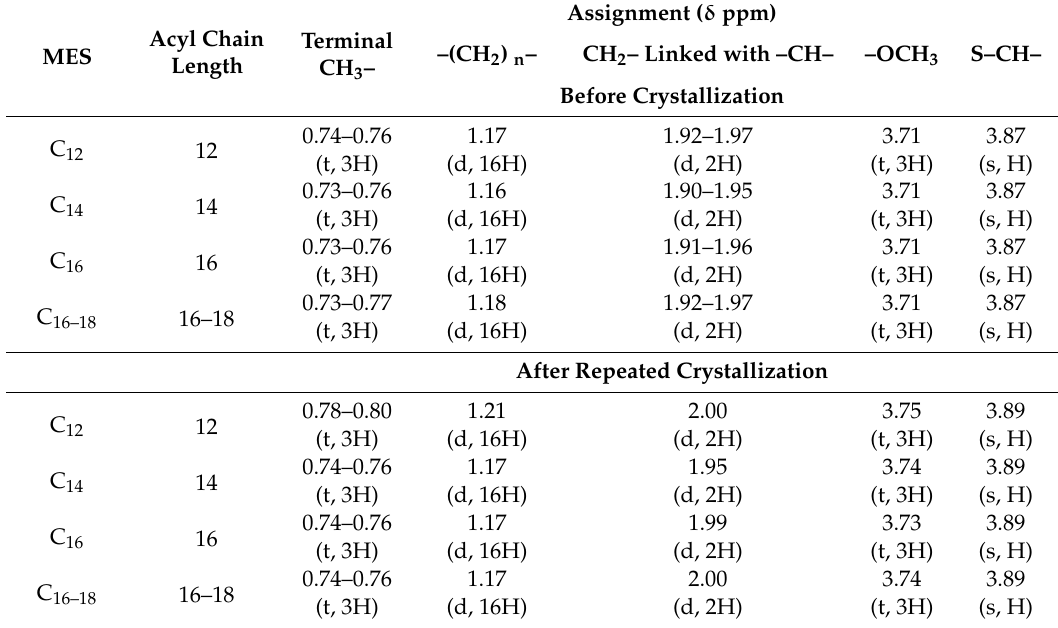
Table 2. NMR spectra data of MES before and after repeated crystallization.